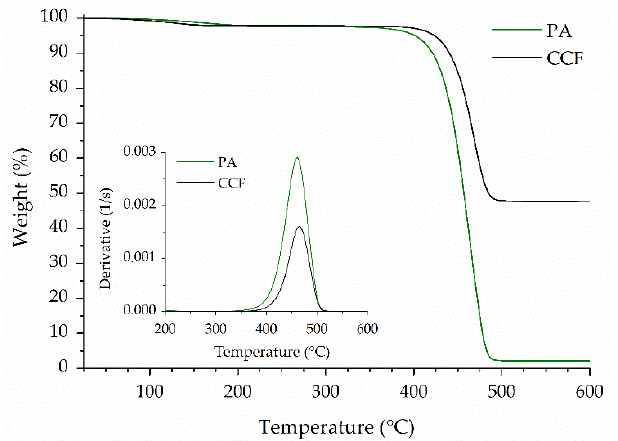
Figure 3. TGA curves in inert environment of PA and CCF filaments showing the different weight loss for the two materials. Insets of Figure 3: weight loss derivative curves that put in evidence the temperatures at maximum degradation rate (T d peak ) of the filaments.